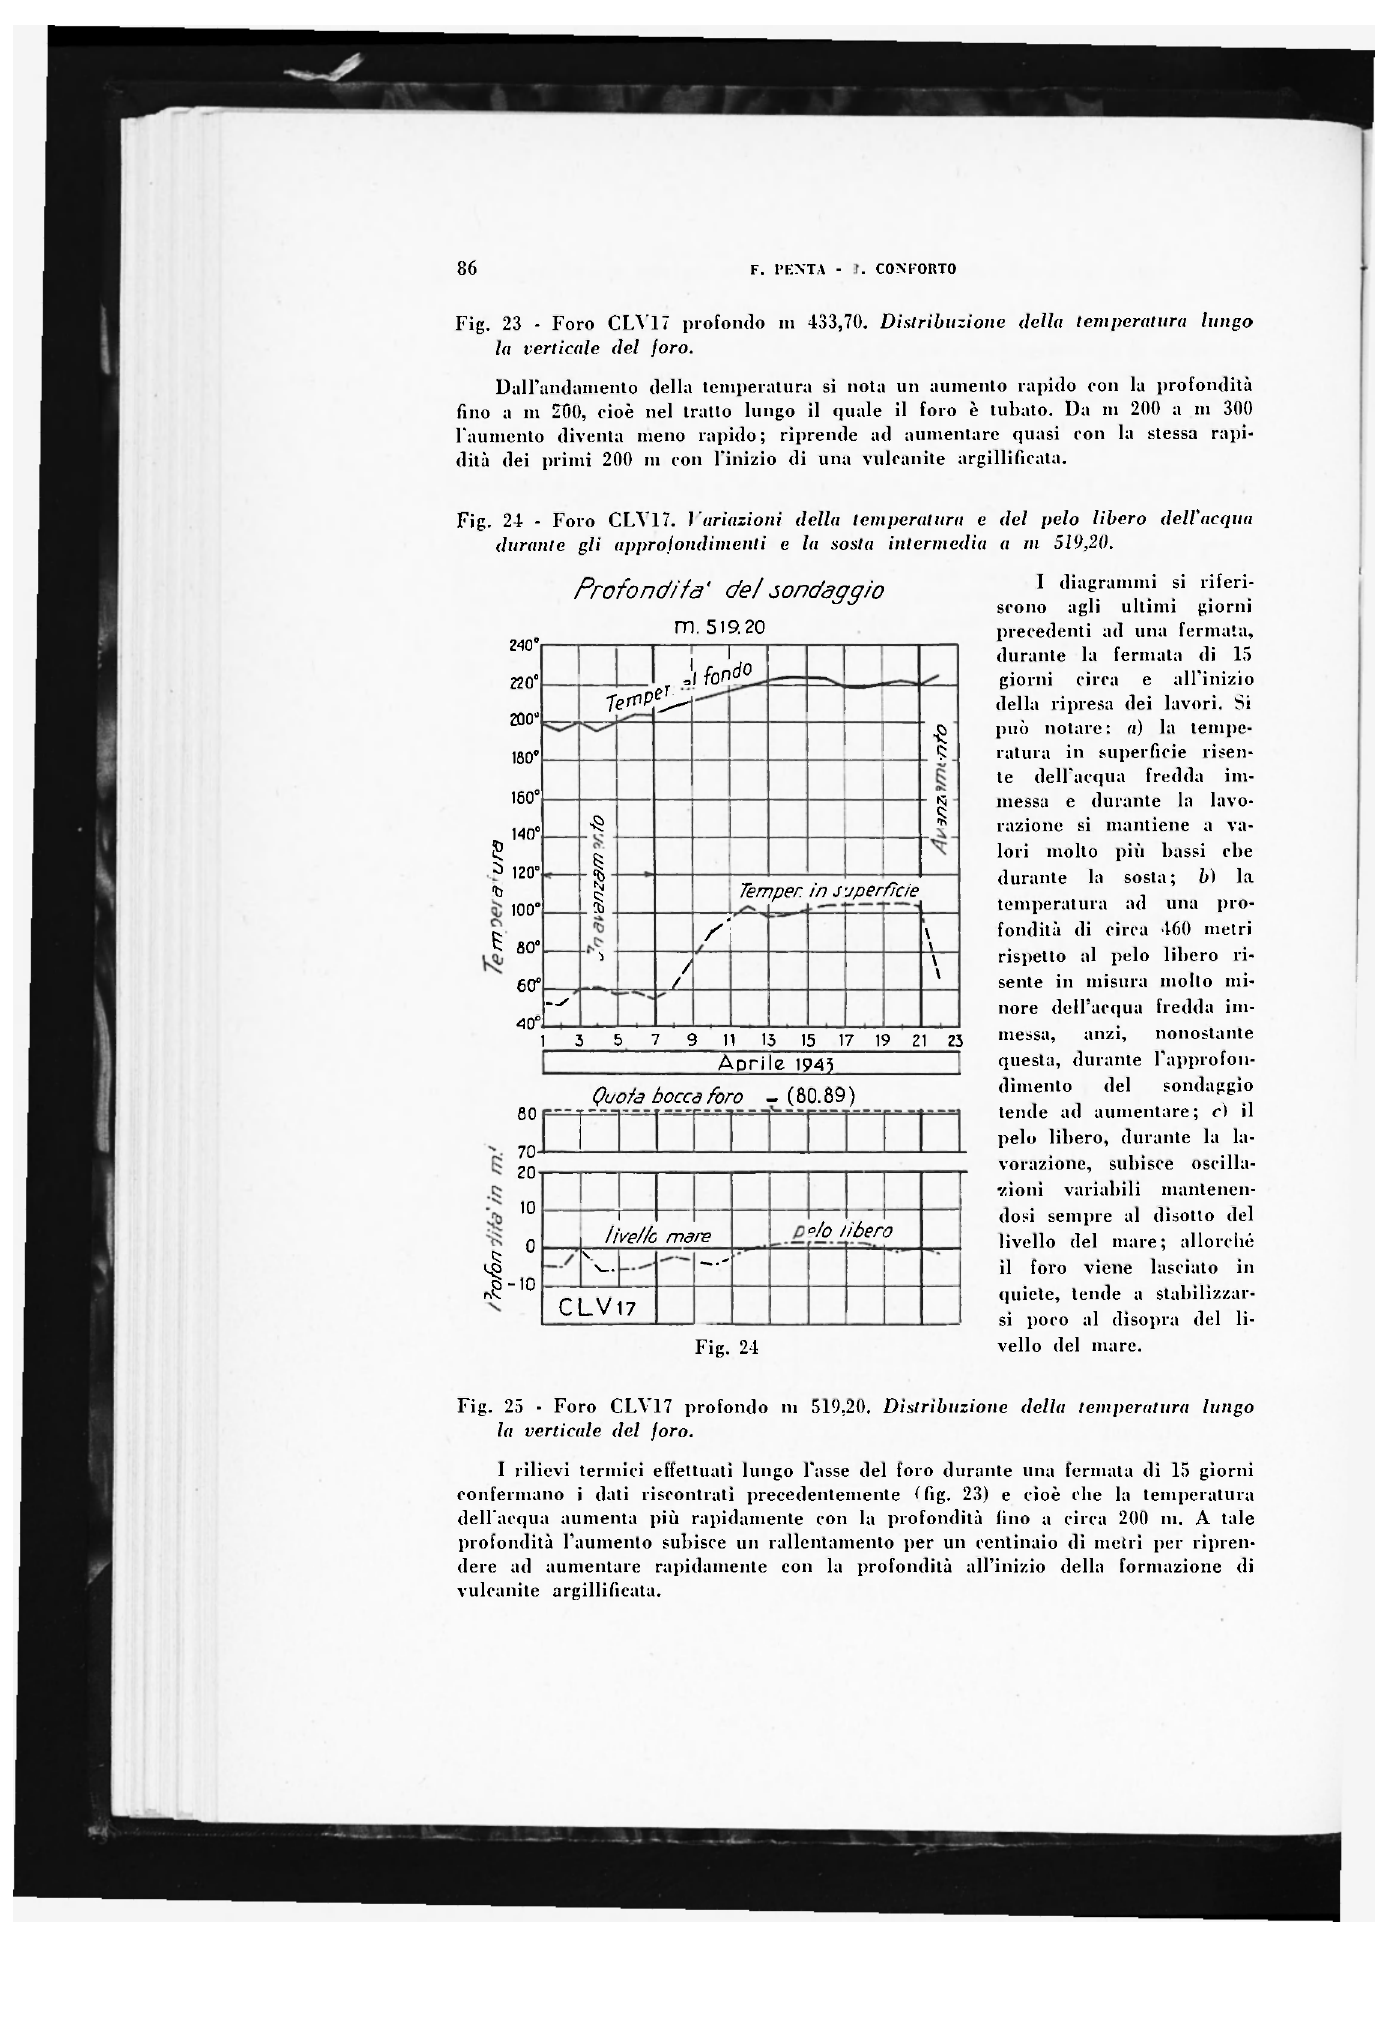
Fig. 23 - Foro CLY17 profondo m 433,70. Distribuzione della temperatura lungo la verticale del joro.